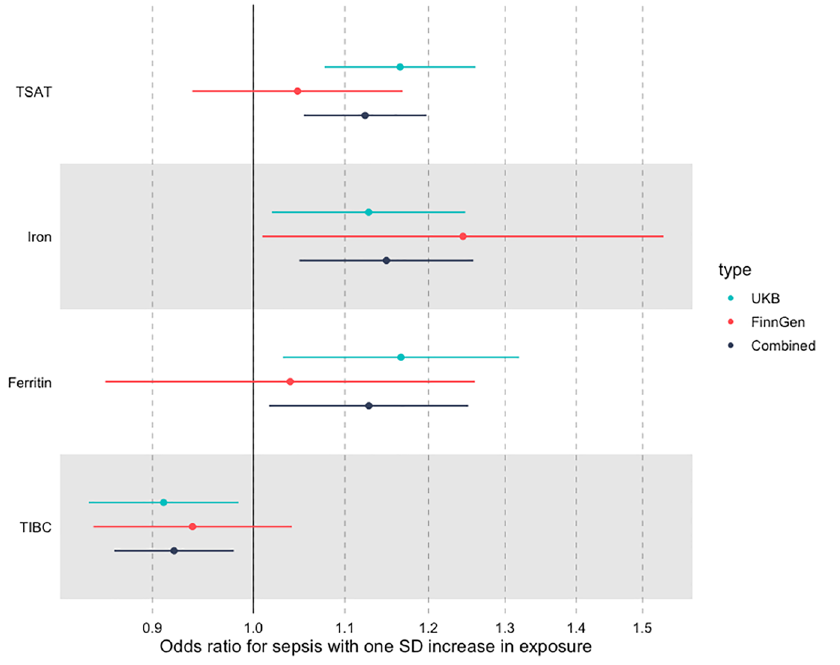
Figure 5. Summary IVW MR associations across both FinnGen and UK